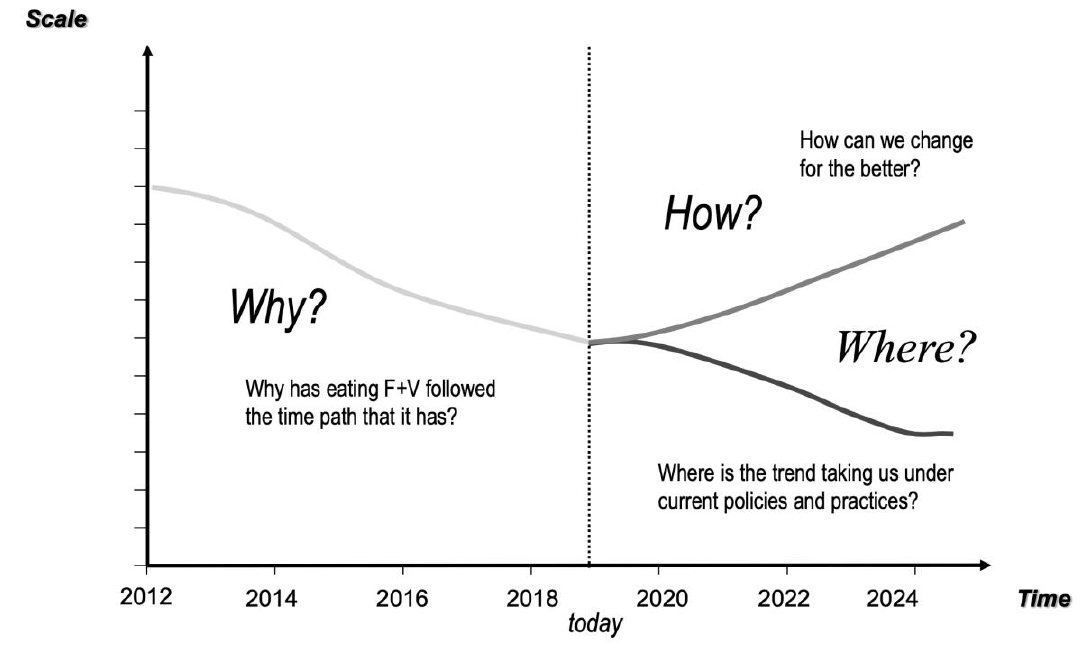
Figure 1. Graphs over time template.